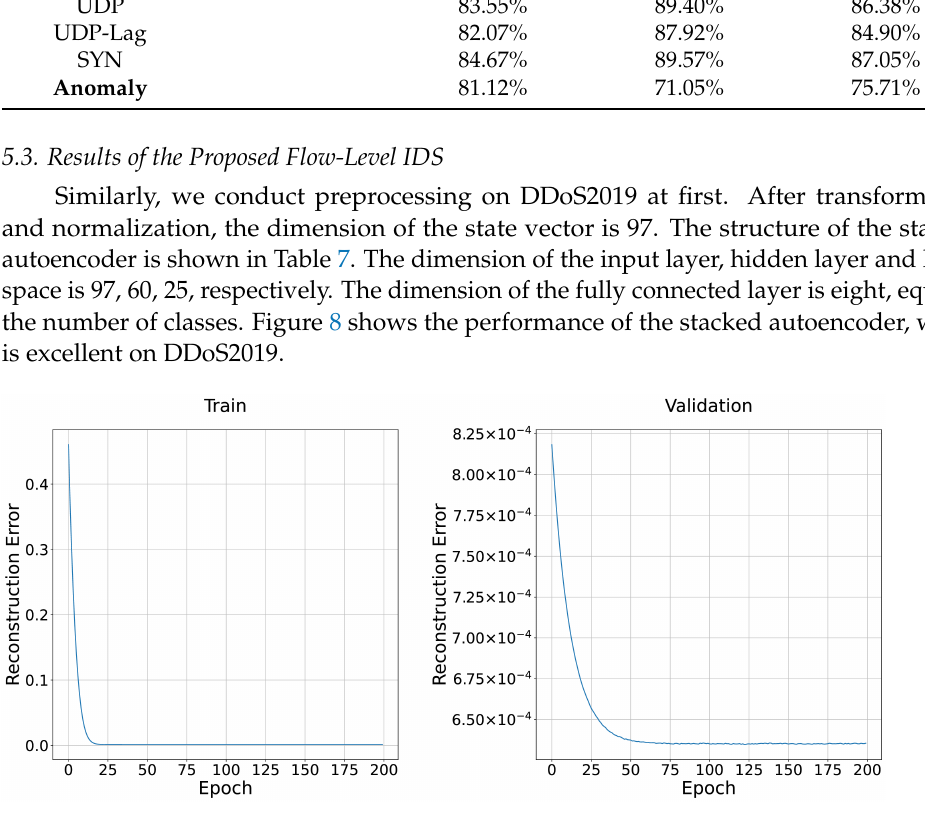
Figure 8. Performances of stacked autoencoder on